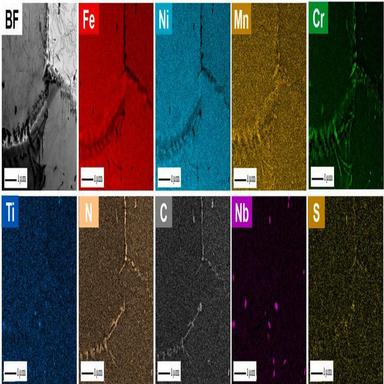
Characterization of Alloy 709 crept at 700 ◦C. The EDX maps show carbide-nitride precipitates rich in Cr, N and C are nucleated along the grain boundaries after the creep test.